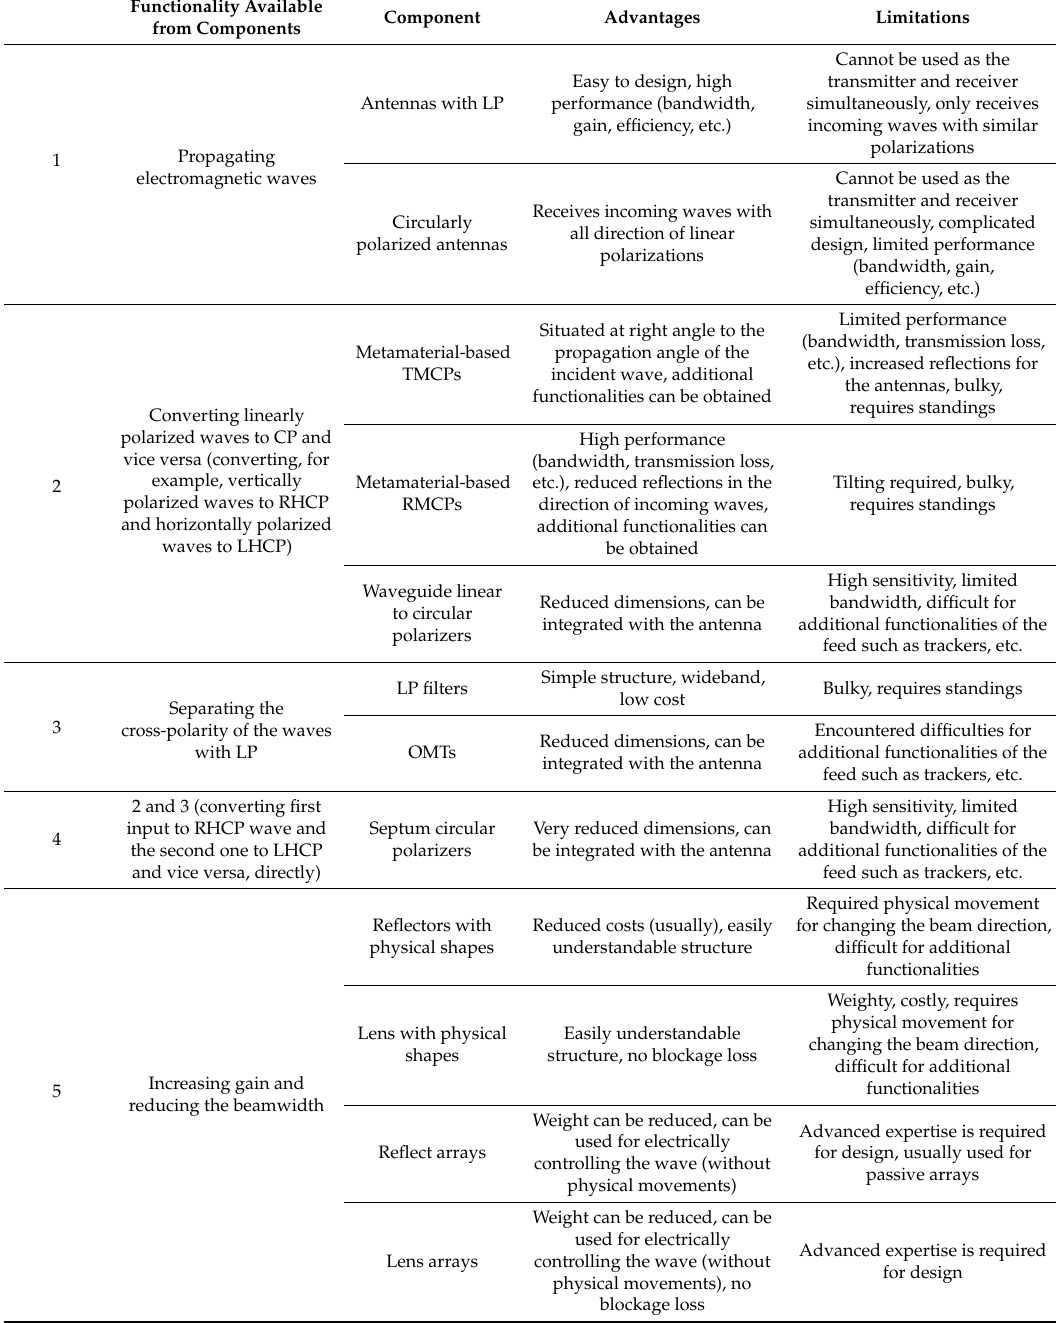
Table 1. Required functionalities from the components, their advantages and